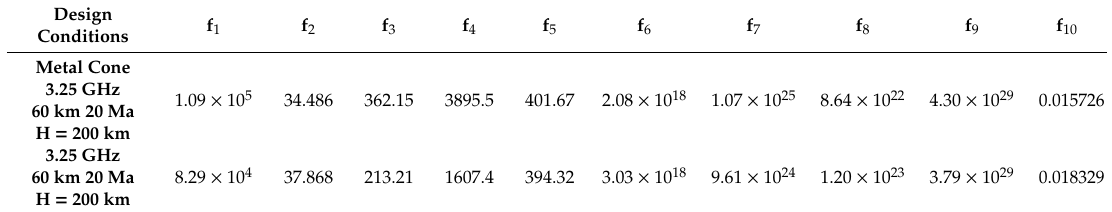
Table 3. Comparisonoftheeffectivestatisticalcharacteristicvaluesdependingonwhetherthehypersonic vehicle is covered with a plasma sheath (f = 3.25 GHz and H = 200 km for the flying parameters 60 km and 20